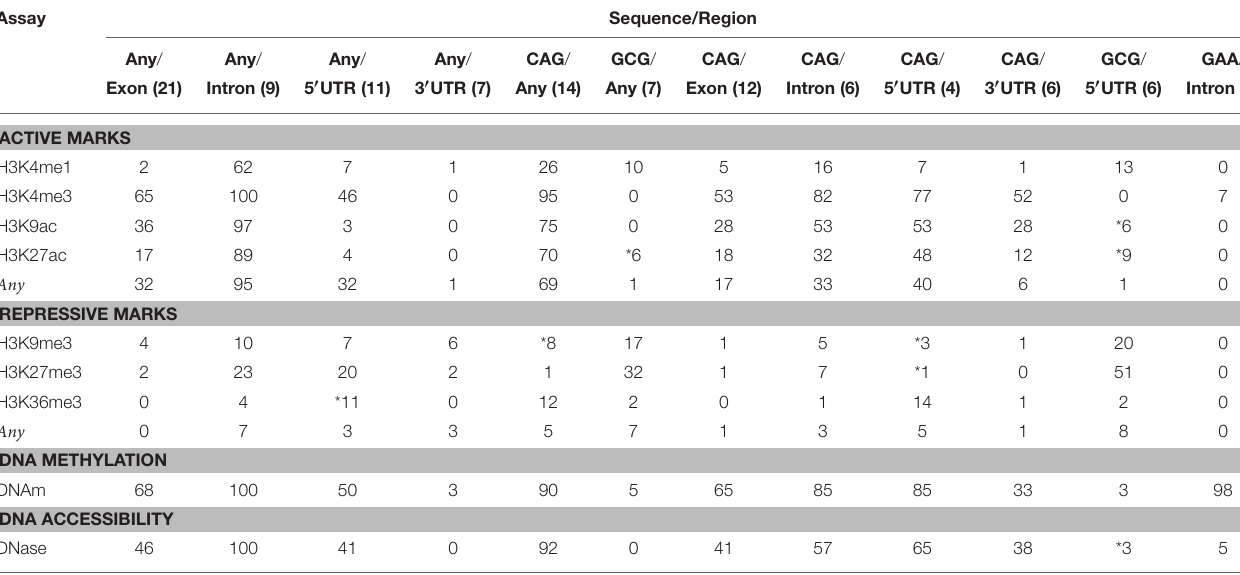
TABLE 3 | Percent of cell types that display over- or under-enrichment for specific epigenetic marks around DA-TNRs per M1 (see Figure 1) where TNRs are grouped by either sequence and/or genic region. Assay